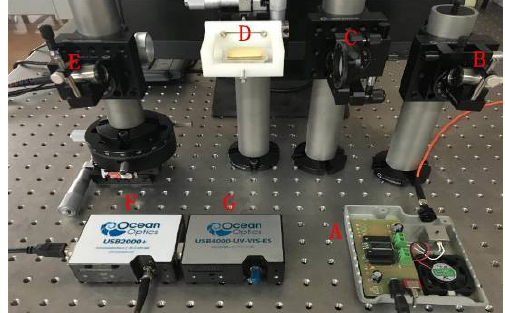
Fig. 10 A self-designed wavelength SPR system with an adjustable incident